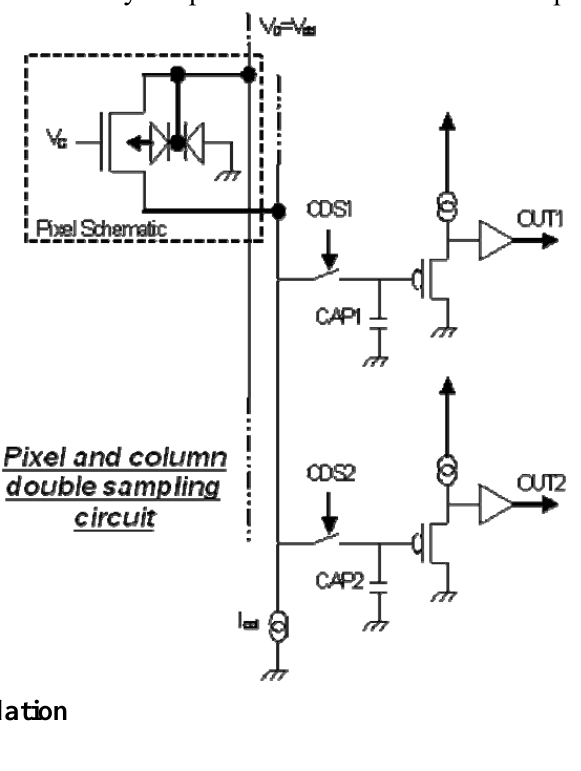
Figure 3. Readout by simple non-correlated double